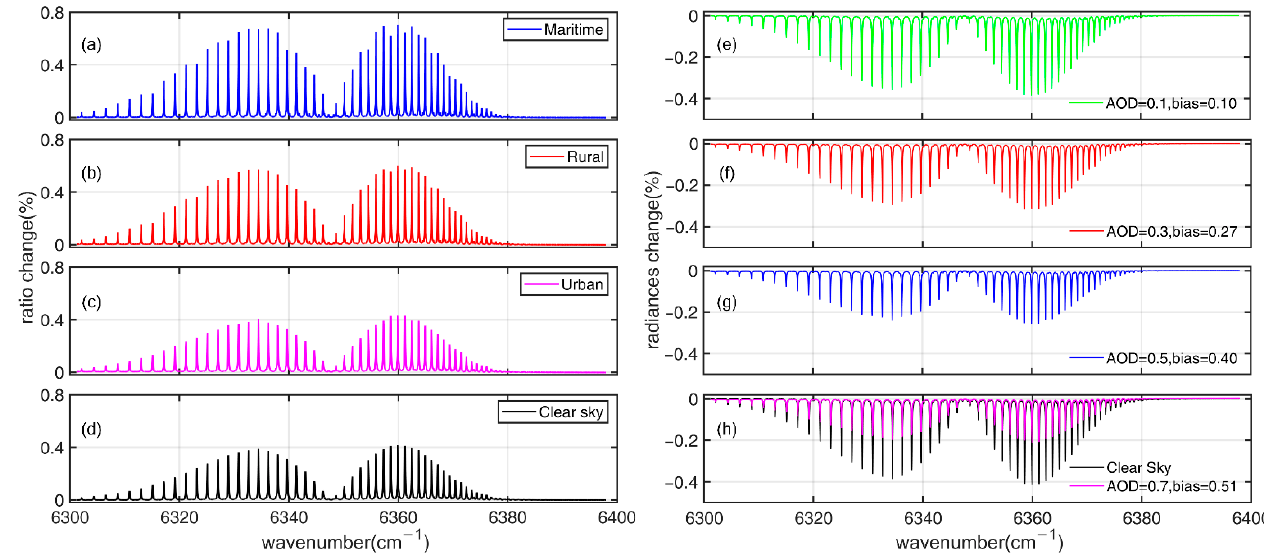
Figure 3. Radiance ratio (on/off) changes when XCO 2 increased by 1% under different atmospheric scenes: ( a – d ) maritime, rural, urban, clear sky; radiance changes when XCO 2 increased by 1% with different AOD ( e – h ) AOD = 0.1, 0.3, 0.5, 0.7, and clear sky.